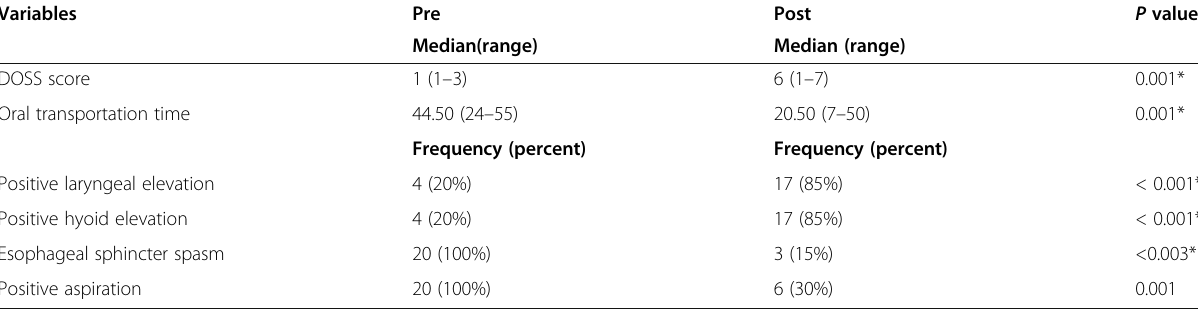
Table 2 Comparison of the DOSS score and different components of the digital fluoroscopic evaluation between pre- and post- treatment in group A Variables